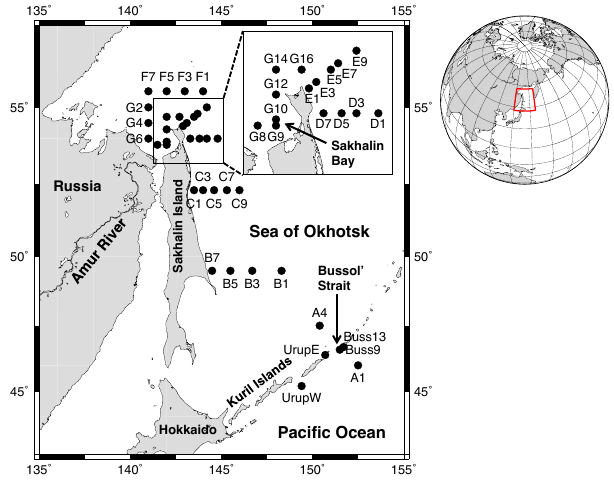
Fig. 1. Maps of the Sea of Okhotsk and its adjacent waters. Closed circles indicate our sampling stations during the R/V Prof. Khromov cruise between 13 August and 14 September